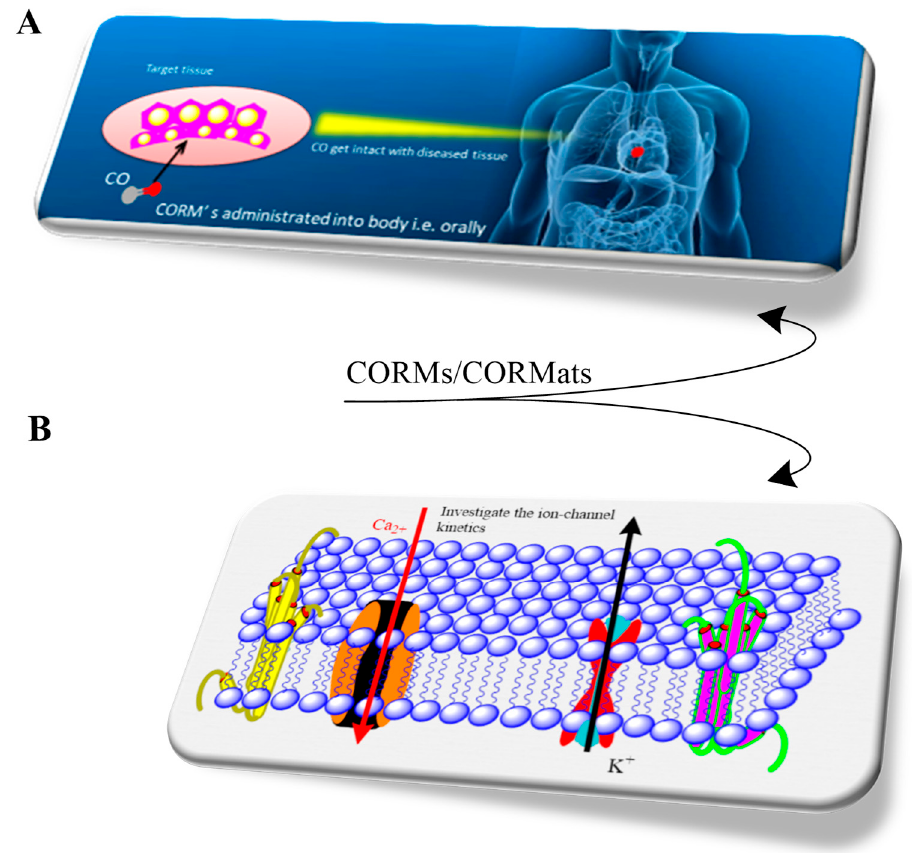
Figure 28. The CO-releasing rate profile reflects the di ff erent characteristics: ( a ) Slow CO release has Figure 28. The CO ‐ releasing rate profile reflects the different characteristics: ( a ) Slow CO release has therapeutic significance; ( b ) fast CO release demonstrates the path of ion-channel therapeutic significance; ( b ) fast CO release demonstrates the path of ion ‐ channel kinetics.